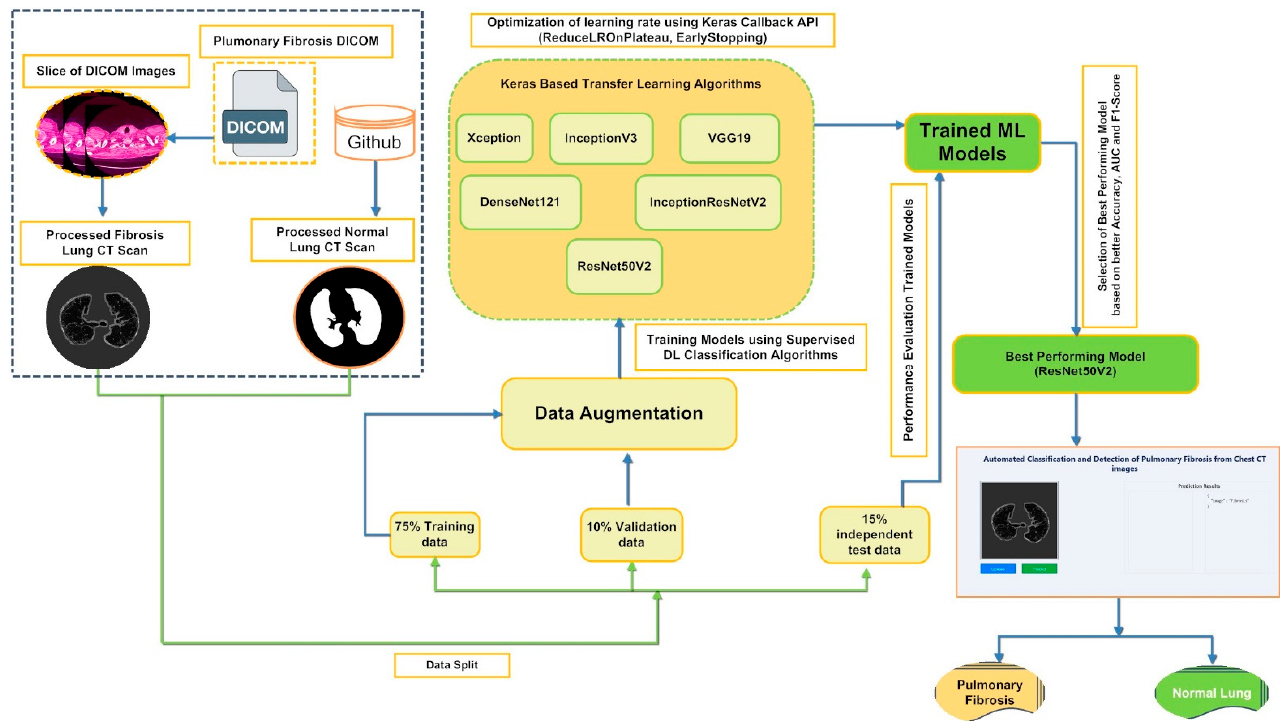
Figure 1. Workflow outlining the framework for classifying and detecting Pulmonary Fibrosis in chest CT scan slices.